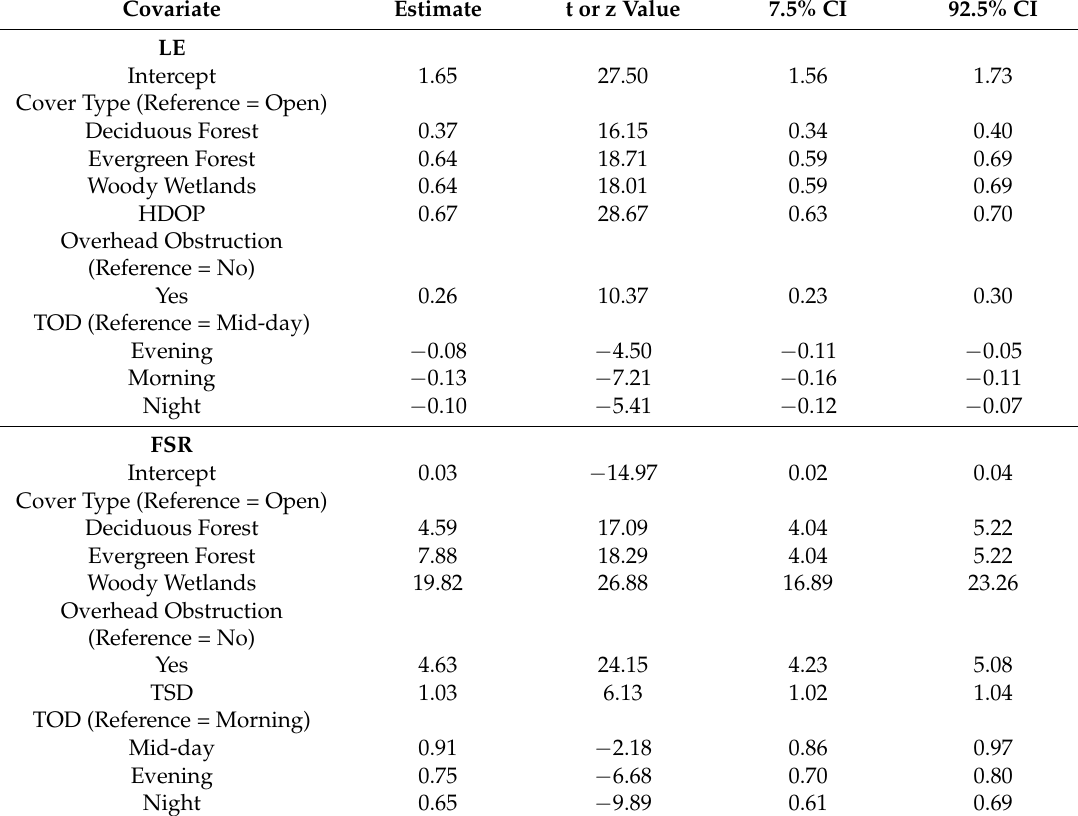
Table 2. Coefficients for the top-ranked mixed-effect linear model for location error (LE) and mixed-effect logistic model for fix success rate (FSR) for GPS stationary tests in northeastern Minnesota. All values for LE were logarithmically transformed to meet the assumptions of the model. The covariate estimates for FSR are odds ratios and are significant because the 85% confidence interval on each estimate does not overlap 1. Odds ratios >1 suggest the reference has a higher FSR than the alternative and odds ratios <1 suggest the alternative has a higher FSR than the reference. Predictor variables for both models include cover type, whether the test was located under an overhead obstruction, and time of day (TOD). Horizontal dilution of precision (HDOP) was included as a predictor variable for LE and time since deployment (TSD) for FSR. In addition, t and z values for LE and FSR, respectively, and 7.5% and 92.5% confidence intervals (CI) for all estimates are included. These models included a random intercept for GPS receiver